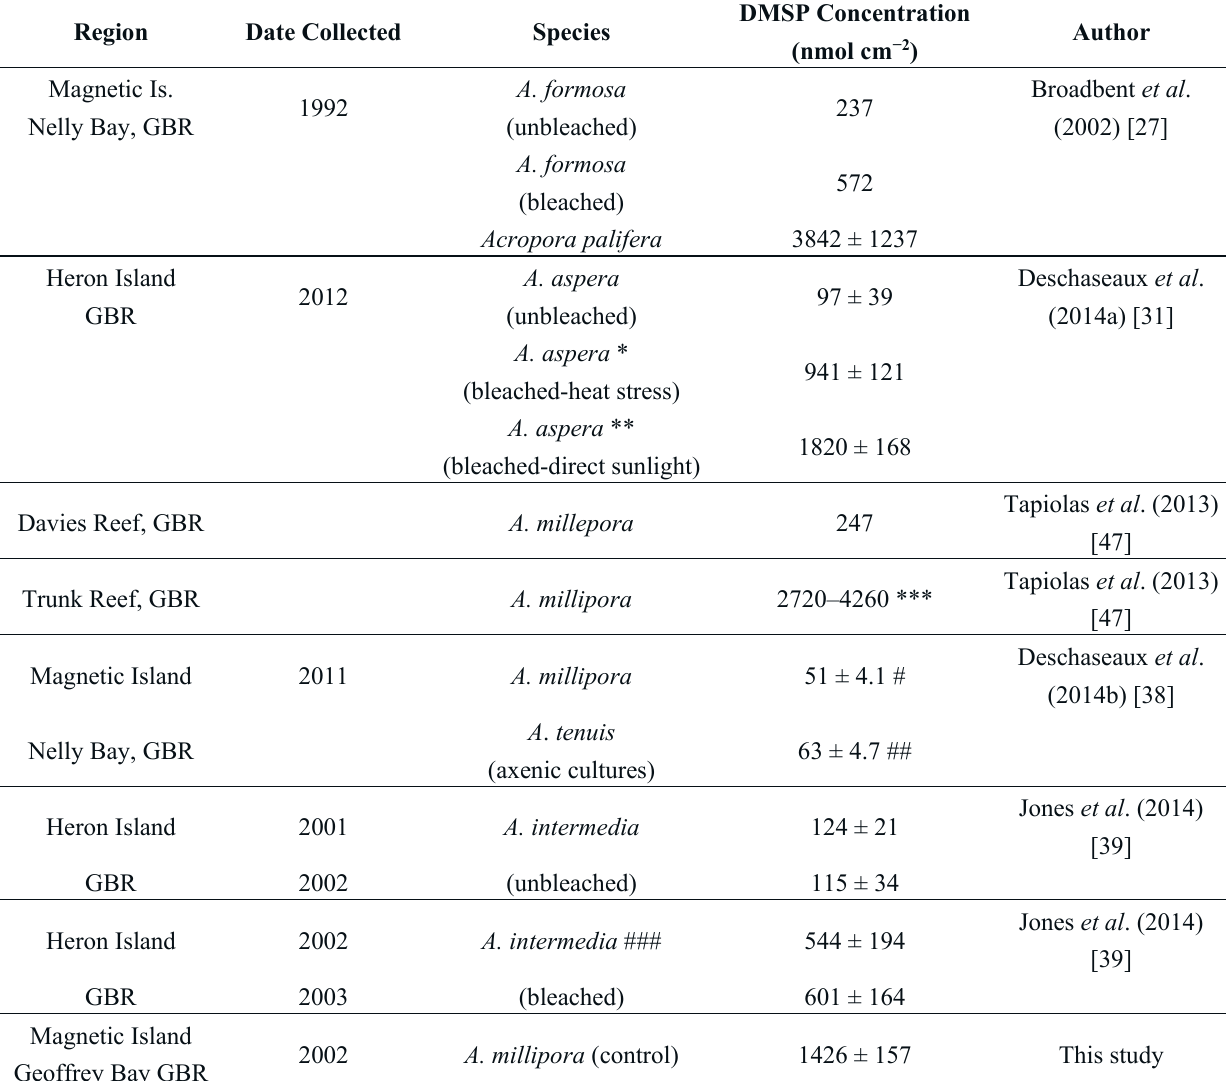
Table 4. Cellular DMSP and acrylate concentrations (nmol cm − 2 ) in different coral species collected from different locations and different times from the Great Barrier